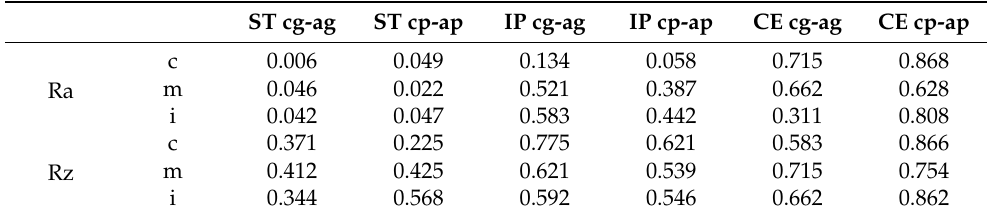
Table 5. The paired t -Test test ( α = 0.05)- p values regarding Ra, Rz for control glazed–agedglazed, respectively control polished–aged polished groups in each area.